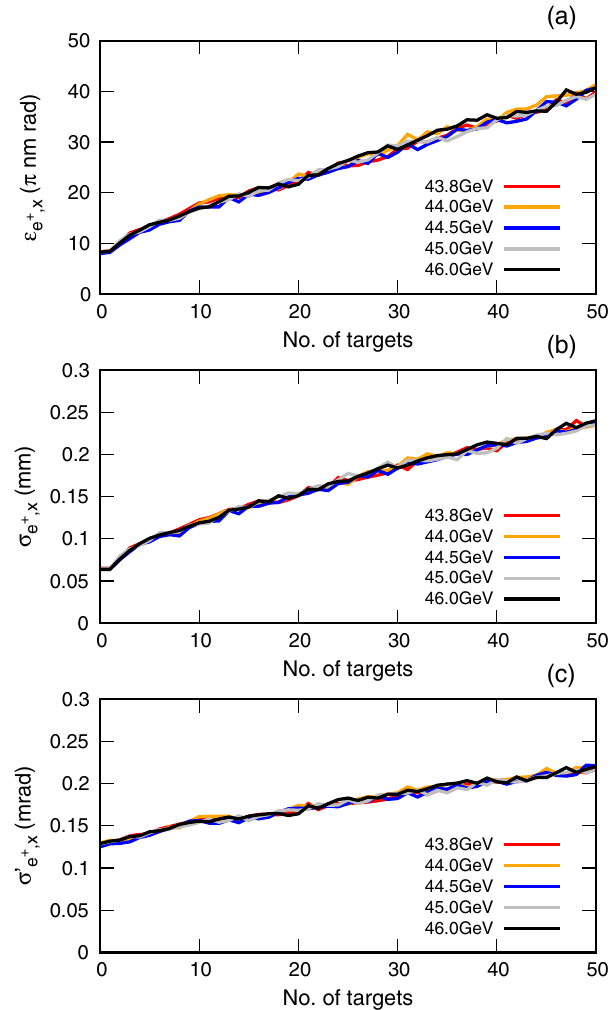
FIG. 9. Positron bunch degradation versus number of targets, 1% X 0 of Be each, for five different beam energies: (a) Horizontal emittance ϵ e þ ;x , (b) beam size σ e þ ;x and (c) divergence σ 0